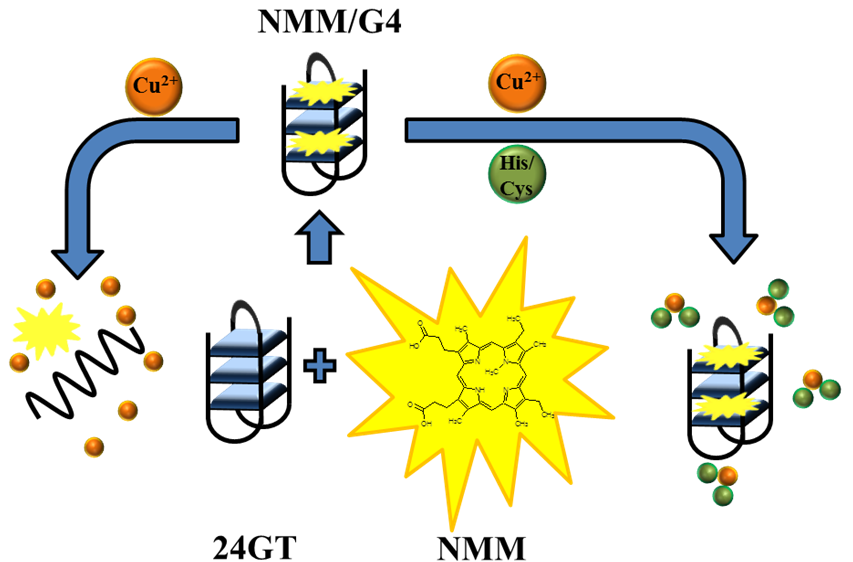
Figure 4. Schematic illustration of the fluorescence change of the NMM/G-4 ensemble under different conditions. The combination of NMM and an intramolecular G-quadruplex generated from 24GT oligonucleotide functions as a signal indicator NMM/G-4 with strong fluorescent intensity. Cupric ion can quench the fluorescence of NMM/G-4 through its coordination with NMM as well as the unfolding of G-quadruplex by Cu 2+ (as shown in the left side). However, the presence of histidine or cysteine can disturb the interaction between Cu and NMM/G-4 complex due to their interaction with Cu 2+ , generating a distinct fluorescence response from that of cupric ion alone (as shown in the right side). Adopted and modified according to Li et al.